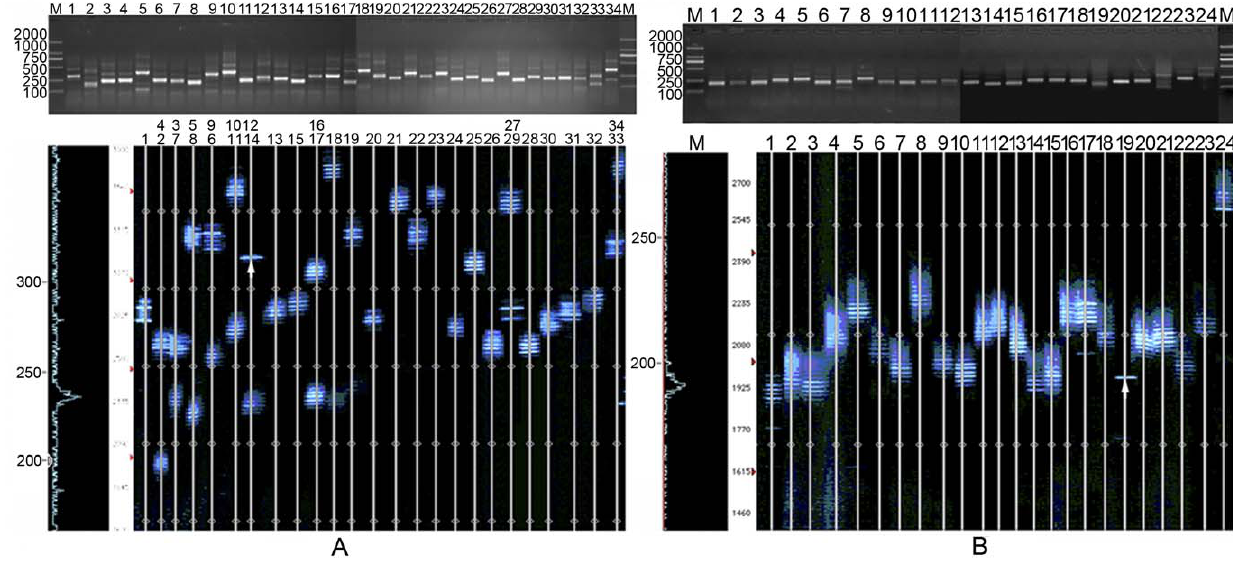
Figure 2. CDR3 spectratypes of TCR families for CD8 + T cells of TB patient-63 (severe group). (A ) The numbers (1–34) denote the corresponding PCR products for TCR families V a 1–V a 34. In the sequencing gel, Lanes 2–7, 10, 20, and 25 include two TCR V a families in one line. (B) The numbers (1–24) denote the corresponding PCR products of TCR families V b 1–V b 24. The lanes with only one bands marked with white arrow.